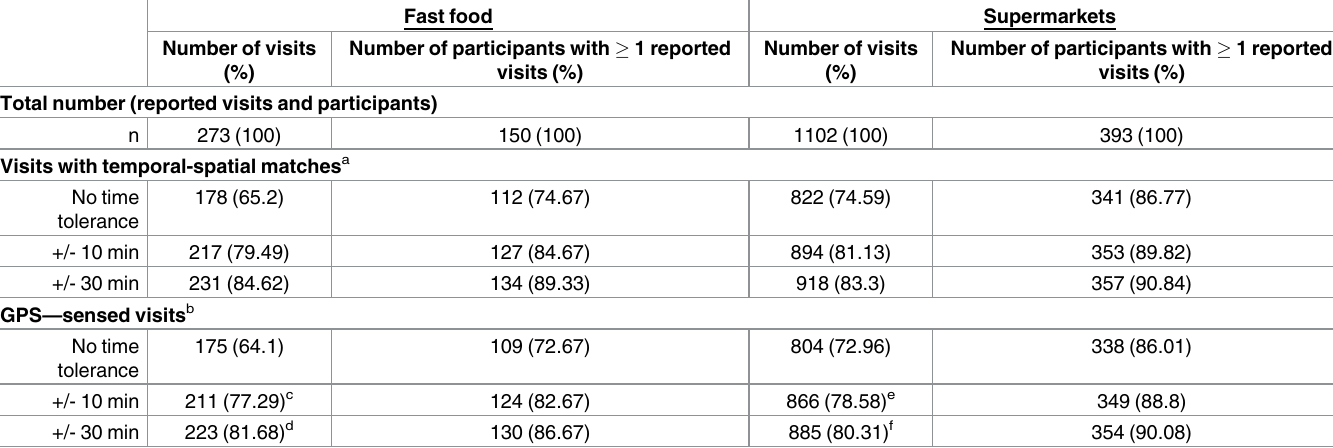
Table 2. GPS—sensed visits using travel diary, GPS, and brand names.